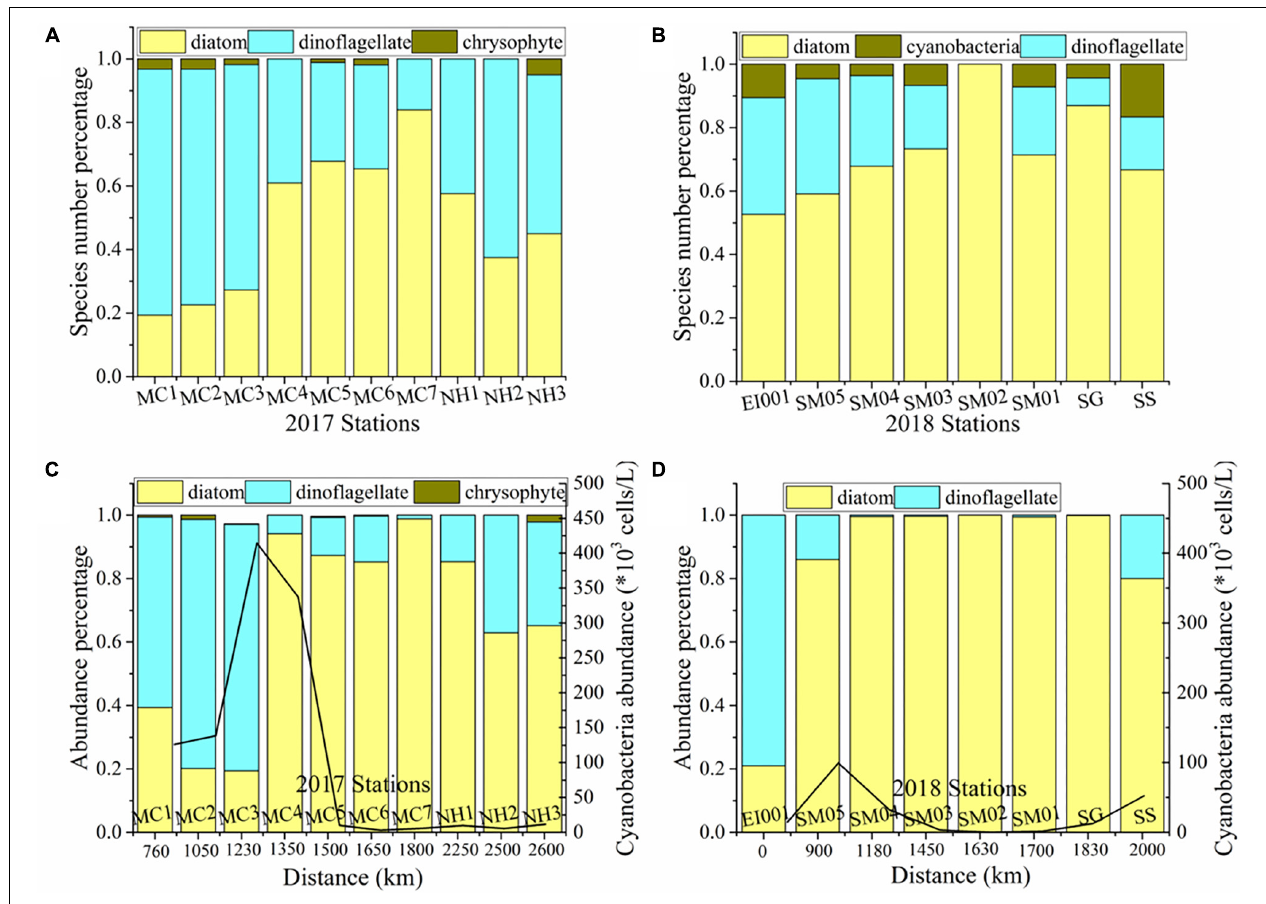
FIGURE 4 | Phytoplankton species number percentage (A,B) and abundance percentage (C,D) among algae groups in each station of two cruises. Scaling bar is the geographical distance from St. EI001 (as an initial